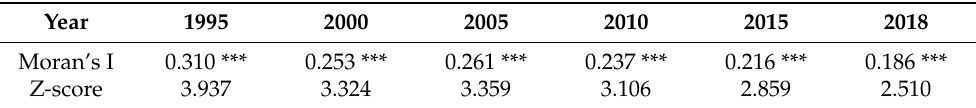
Table 7. Moran’ I of the coupling and coordination degree of urbanization and ecosystem services in the Yellow River Basin,